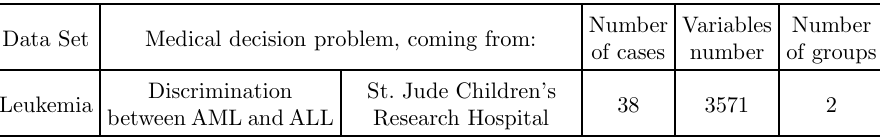
Table 1. Characterization of applied medical data